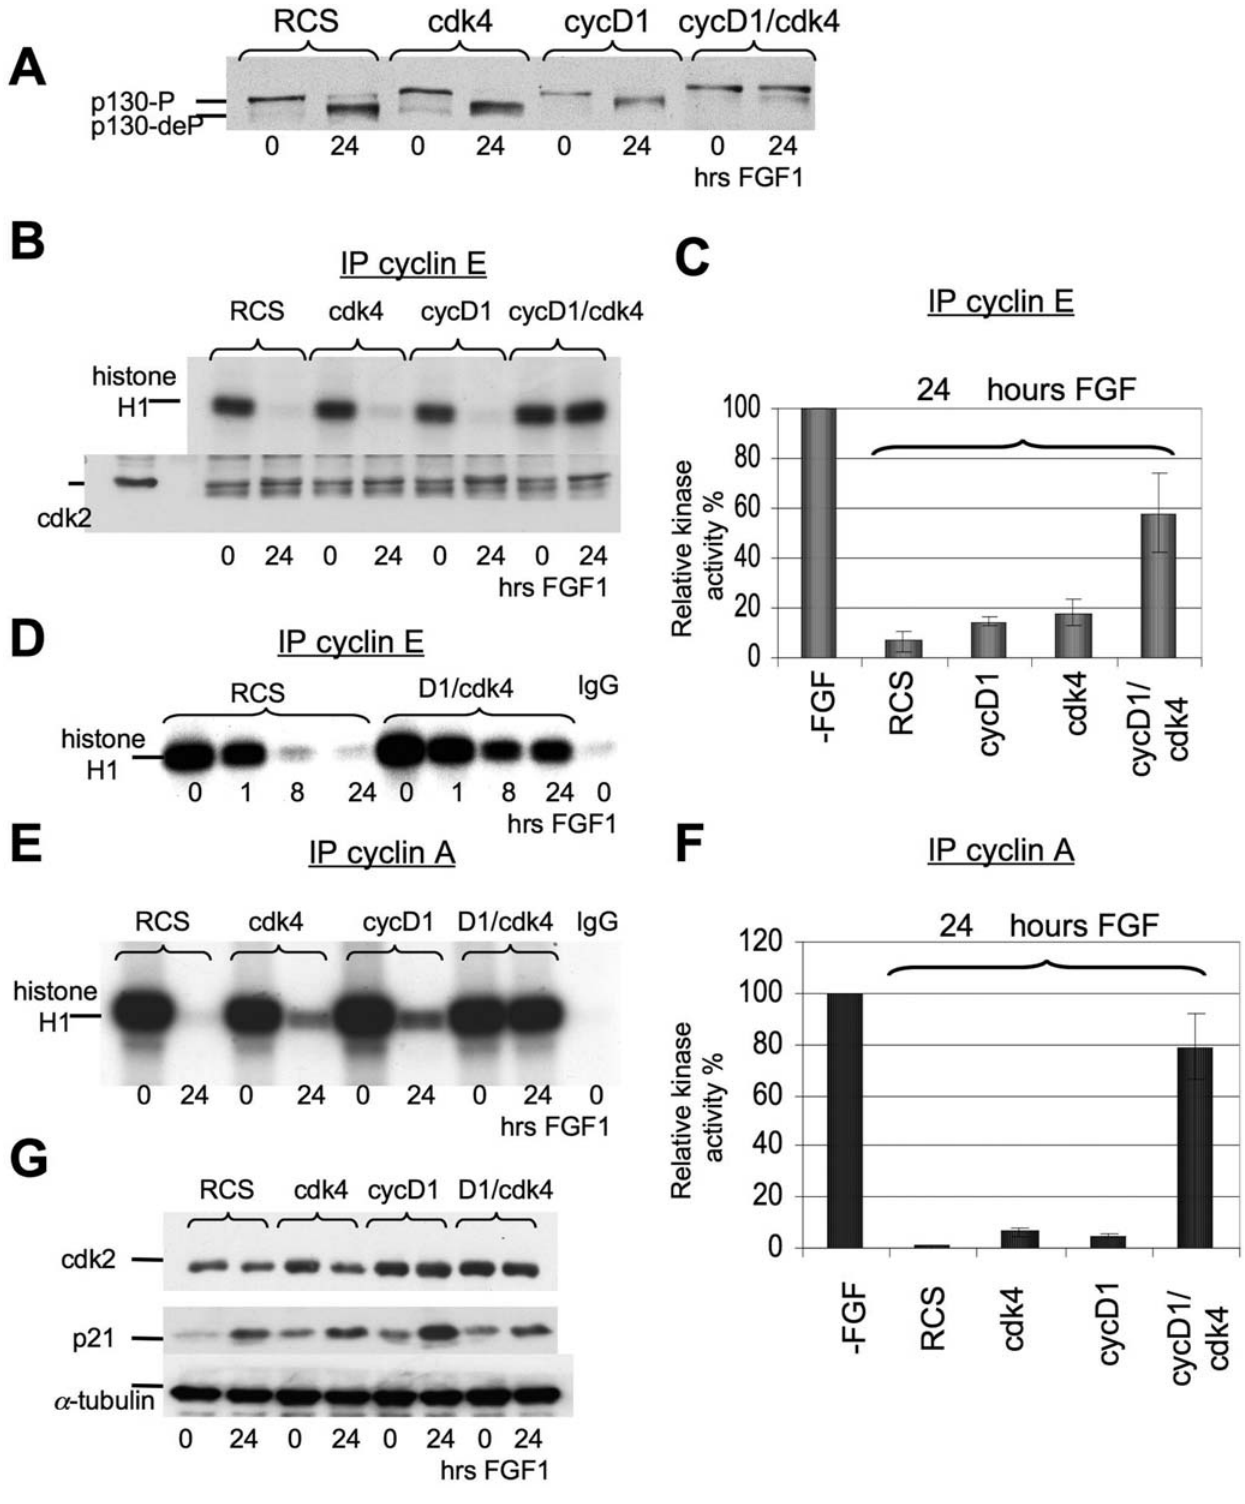
Figure 2. Effect of cyclin D1/cdk4 overexpression on p130 phosphorylation and cyclin E/cdk2 and cyclin A/cdk 2 kinase activities. Parental RCS, cyclin D1, cdk4 or cyclin D1/cdk4 cell lines were treated with FGF1 for the indicated times. (A) p130 dephosphorylation is prevented in cyclin D1/cdk4 expressed cells. 100 m g of total protein was analyzed by SDA-PAGE followed by immunoblotting with anti p130-antibodies. (B, D, E) Kinase activity of immunoprecipitated cyclin E/cdk2 and cyclin A/cdk 2 complexes as assayed in vitro . The cyclin E/cdk2 and cyclin A/cdk 2 complexes were isolated using anti-cyclin E and anti-cyclin A antibodies and histone H1 was used as a substrate. Antibody to mouse IgG was used as negative control. Equal amount of protein loading was confirmed by immunodetection of cdk 2 in immunoprecipitated complexes. (C, F) Summary of results from 3 independent experiments depicting relative levels of cyclinE/cdk2 and cyclin A/cdk2 activities upon FGF treatment in different cell lines. (G) 20 m g of total protein were analyzed by WB, with antibodies against cdk2 or p21. Equal amount of protein loading was confirmed by a -tubulin immunodetection.